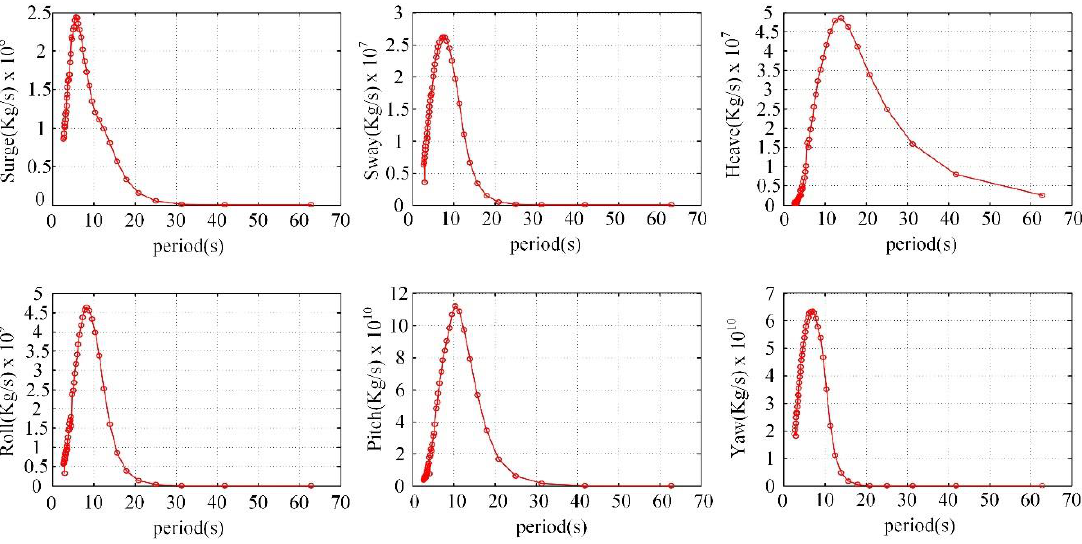
Figure 4. Vessel damping coefficient.